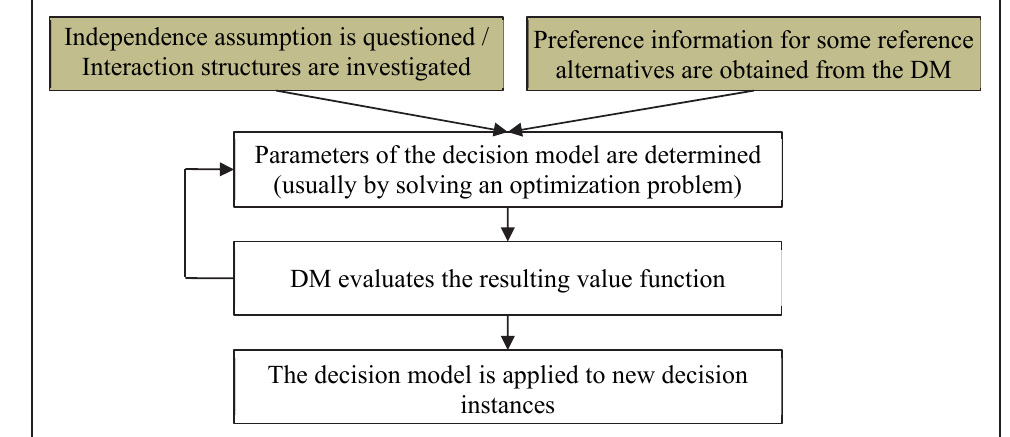
Fig. 10. Framework of the preference disaggregation